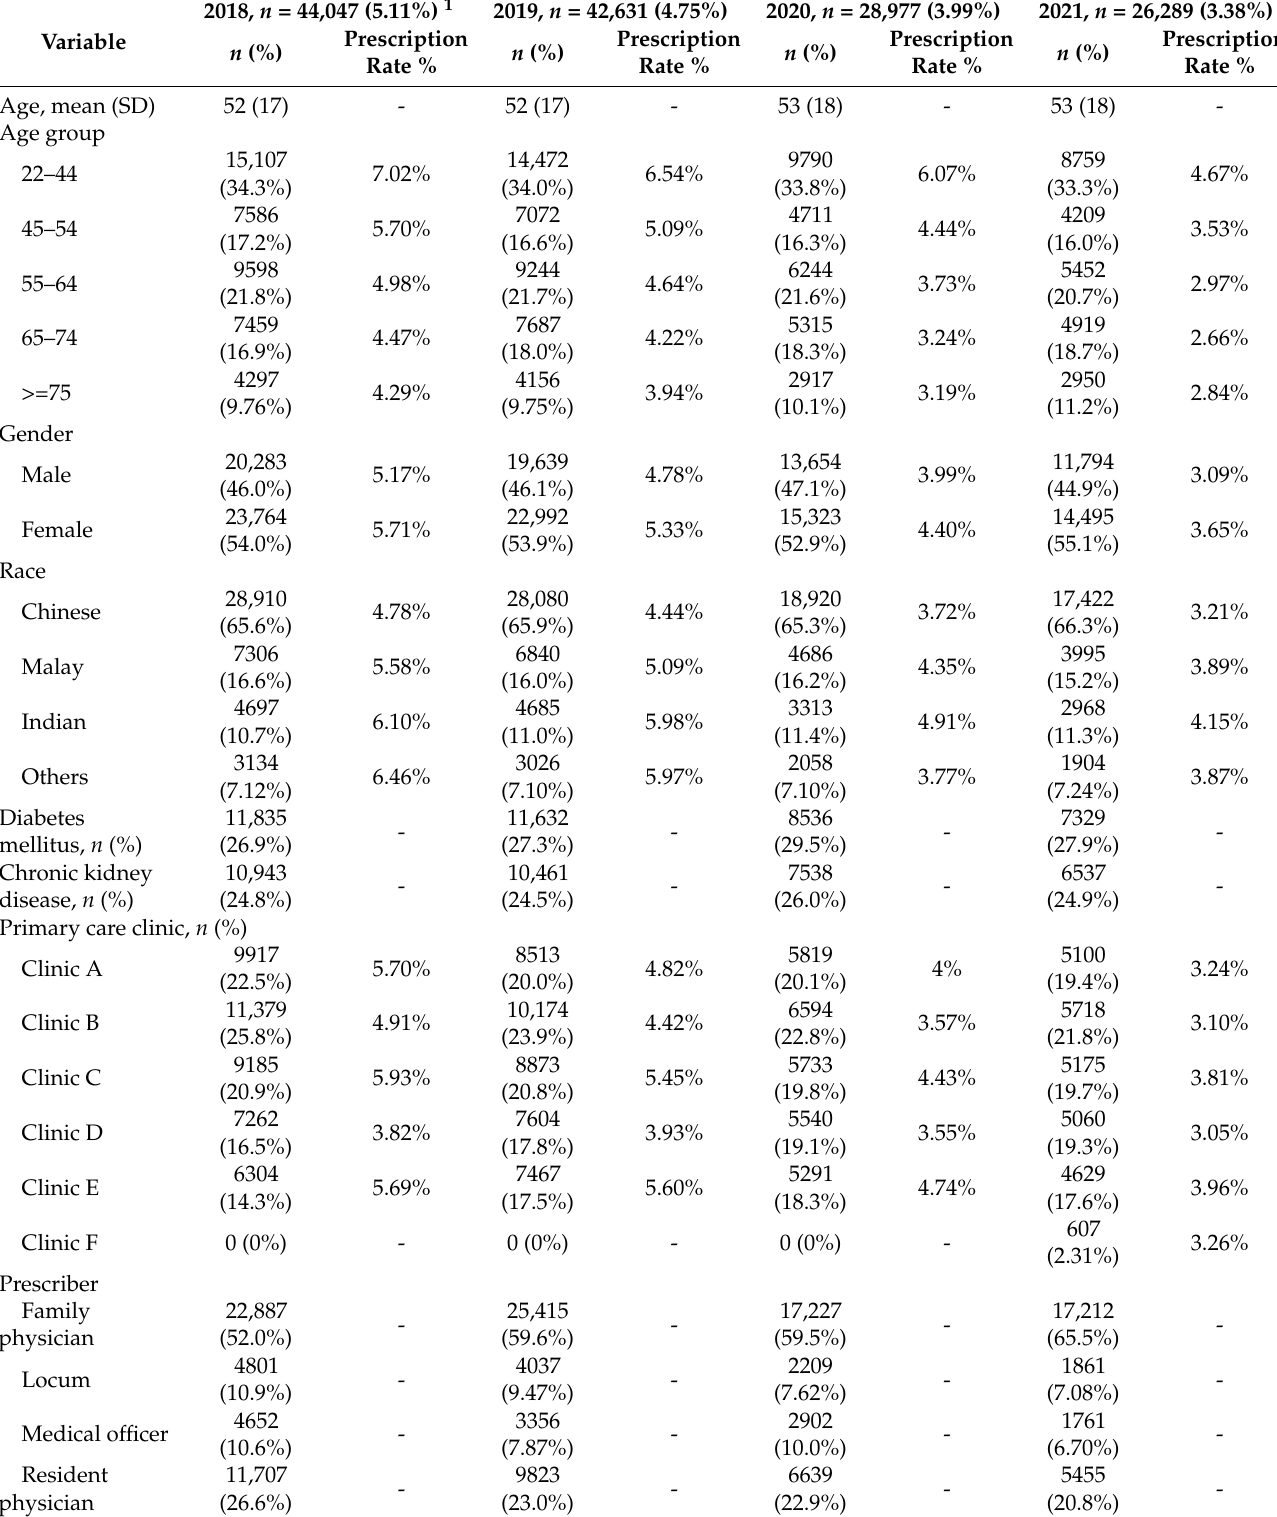
Table 1. Oral antibiotic prescriptions,